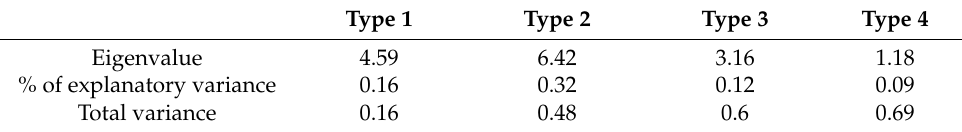
Table 3. Eigenvalue (EVs) and variance between types.